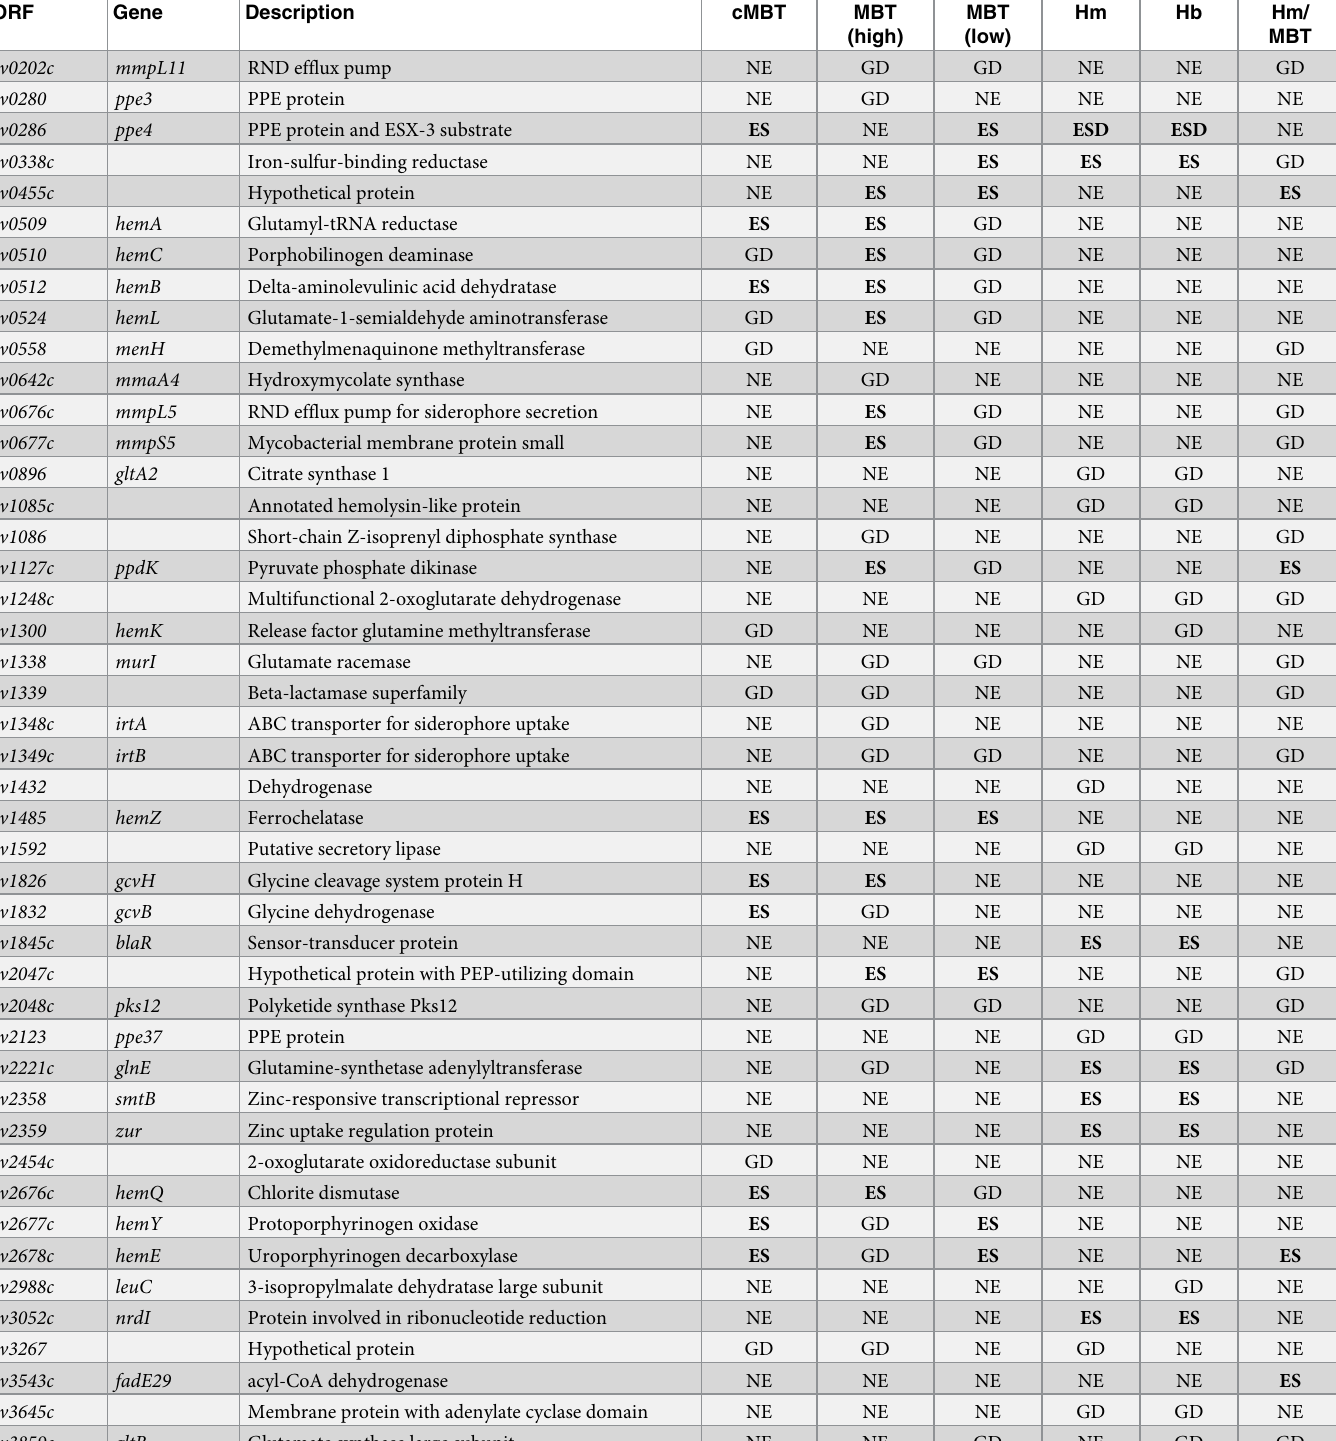
Table 1. Genes with differential importance in iron utilization by Mycobacterium tuberculosis . 45 genes selected from the 165 varying genes which were assessed by HMM analysis as either essential (ES), “essential domain” (ESD) or “growth defect” (GD) under different iron conditions. The 21 genes which were classified as essential or “growth defect” under all iron conditions (S6 Table) were excluded from this list. cMBT: carboxymycobactin, MBT: mycobactin at high or low concentrations, hemin (Hm), hemoglobin (Hb) and hemin plus mycobactin (Hm/MBT). NE: